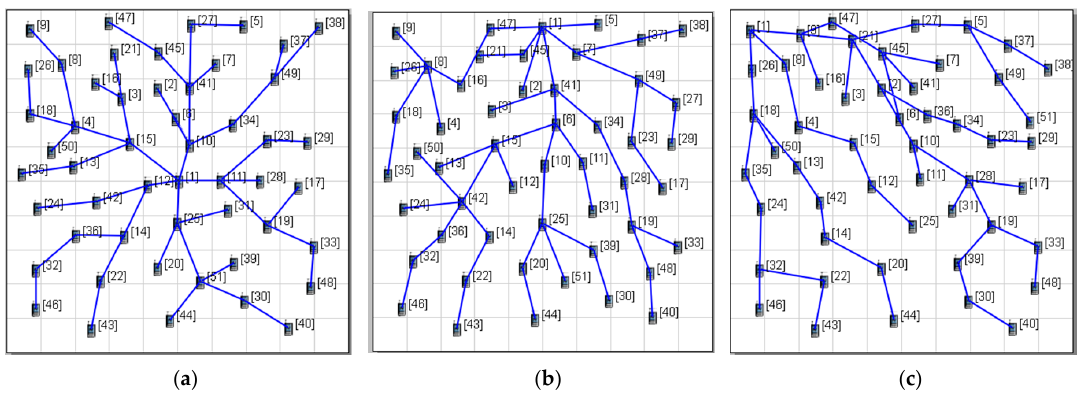
Figure 8. Simulation scenarios: ( a ) S1 with 50 nodes; ( b ) S2 with 50 nodes; ( c ) S3 with 50 nodes.